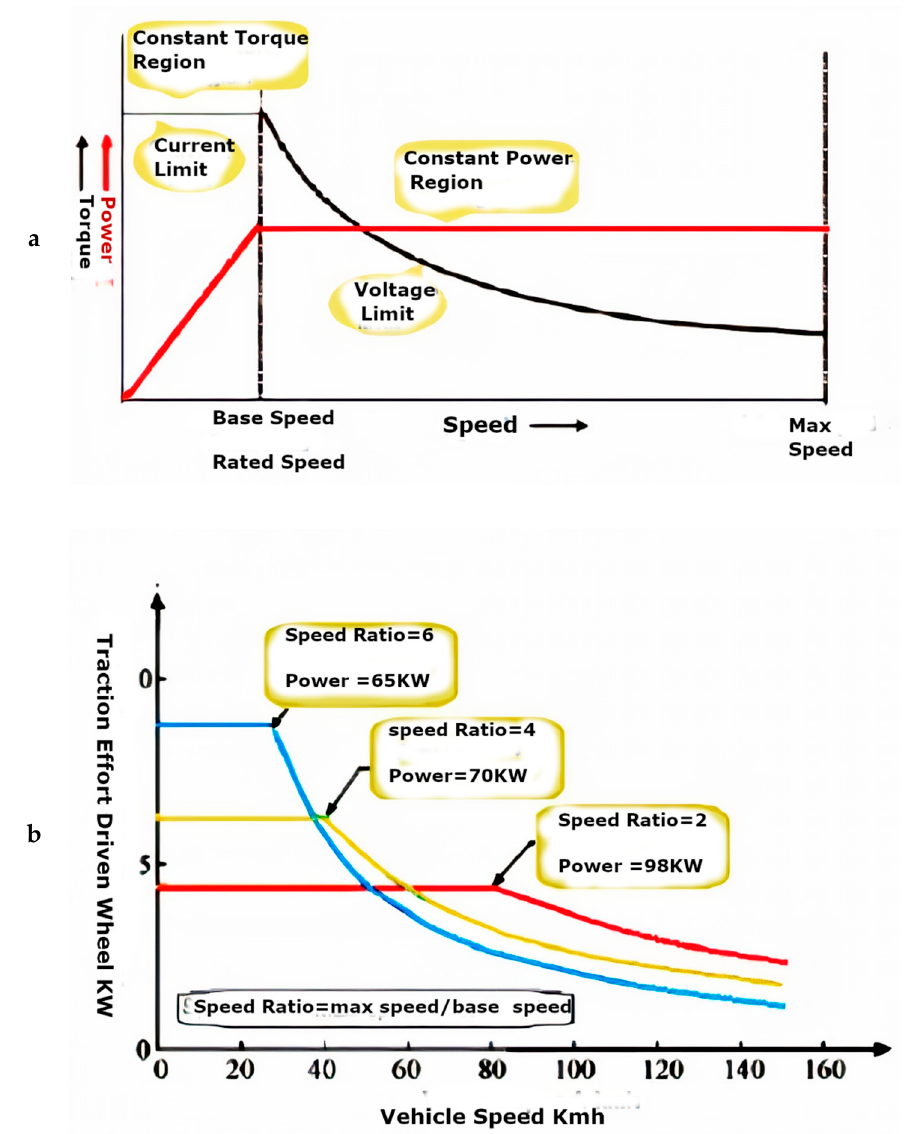
Figure 3. ( a ) Ideal output characteristics of traction motor drive; (b) Tractive effort and power versus vehicle speed with different speed ratios [19].